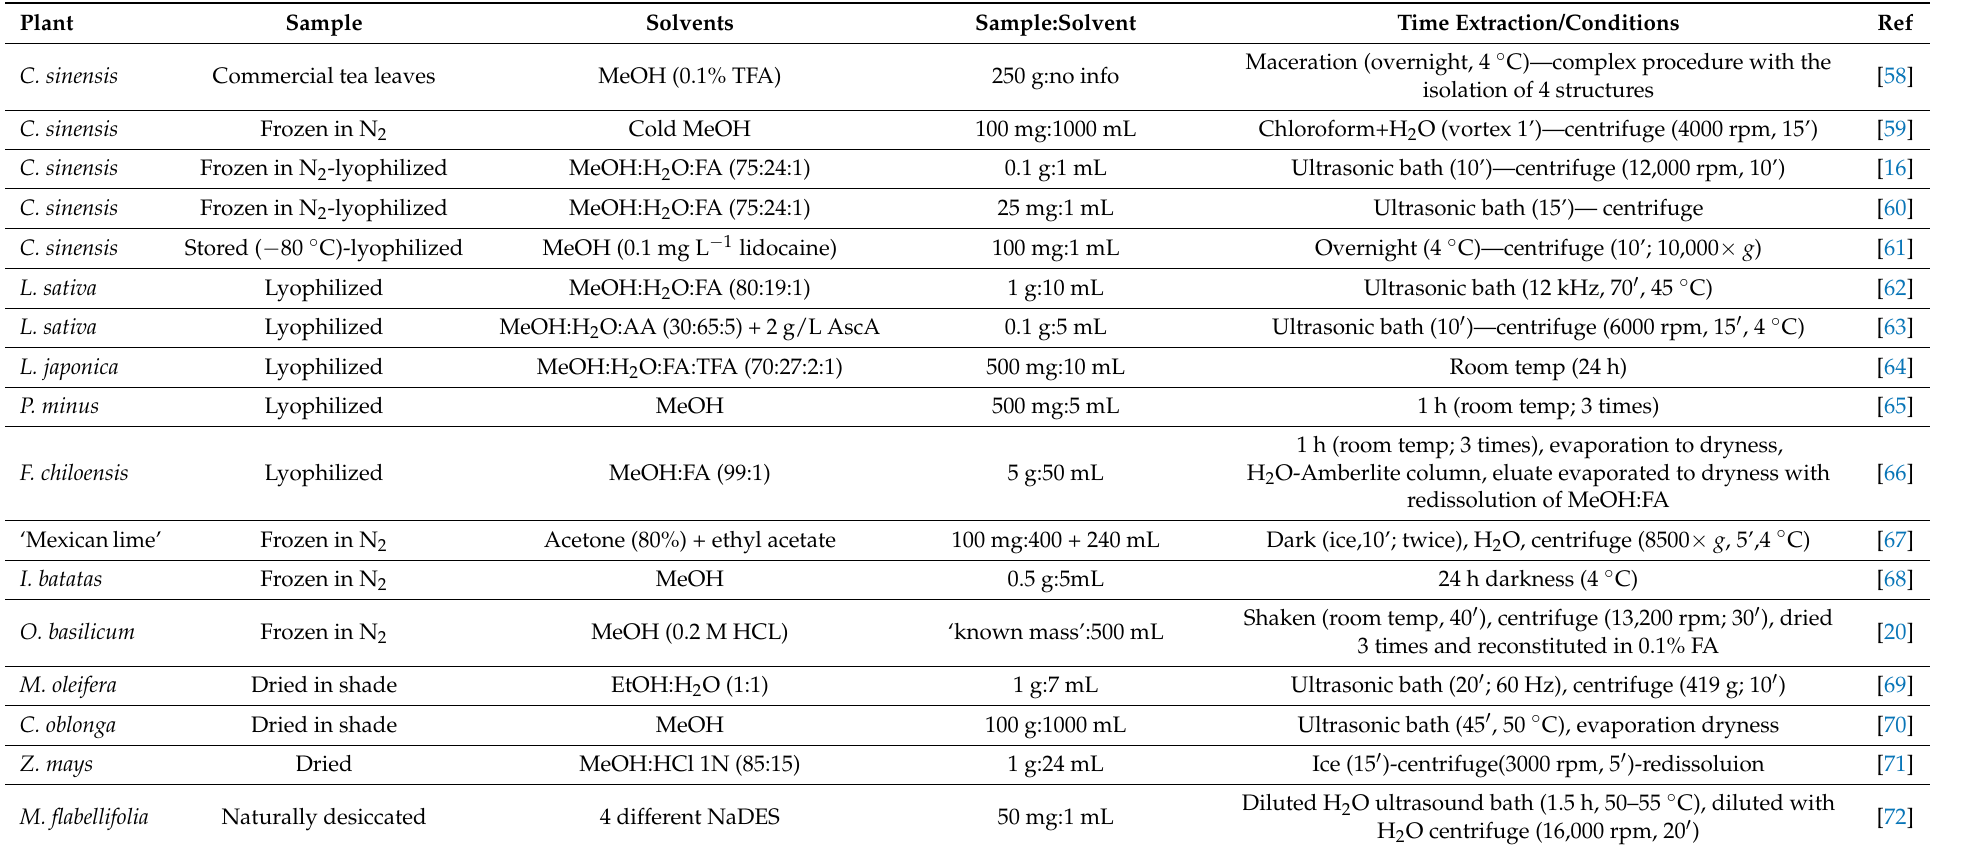
Table 1. Anthocyanins—sample pre-processing and extraction